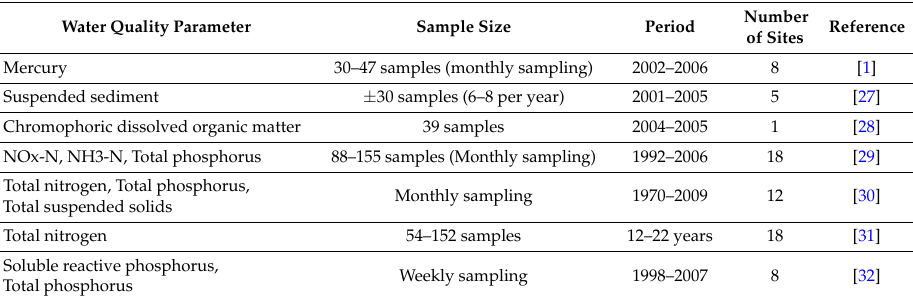
Table 1. Various water quality data for Load Estimator (LOADEST) uses.